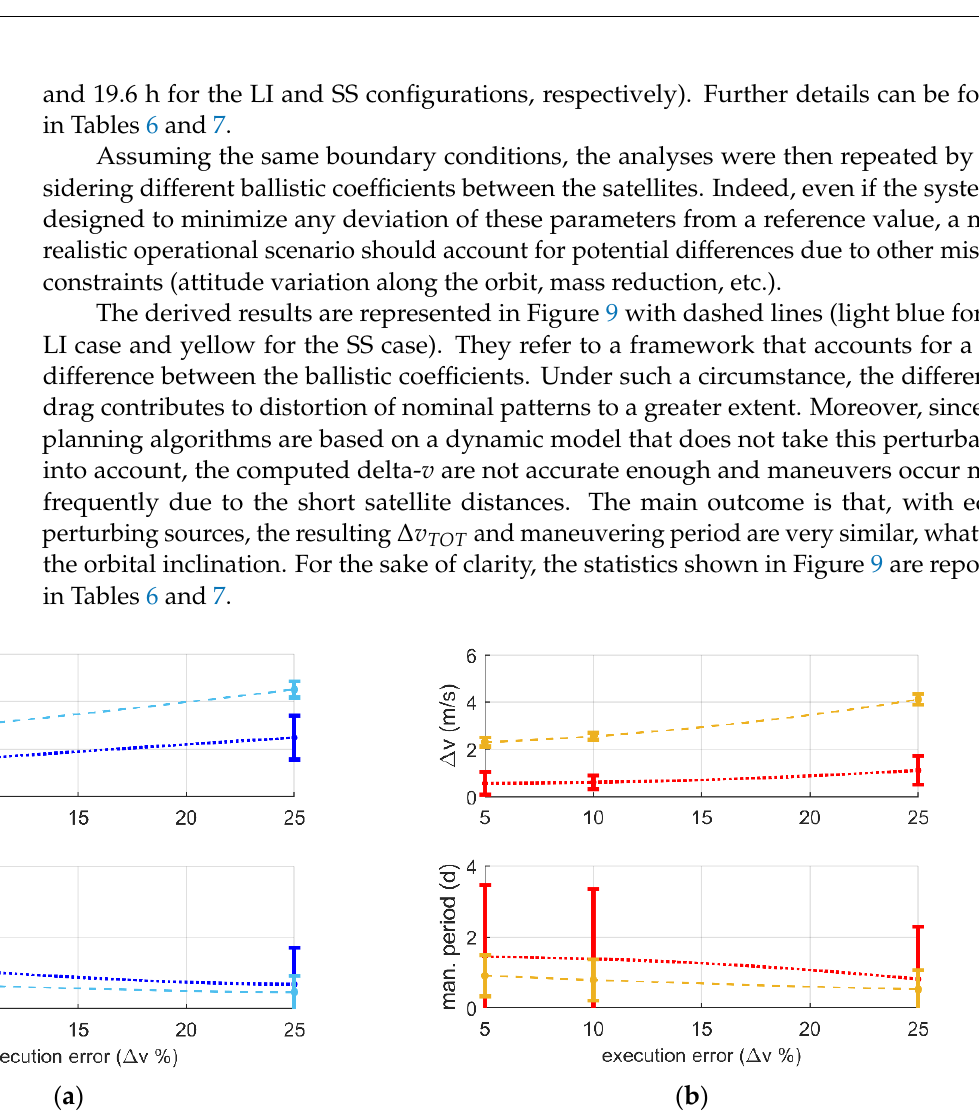
Figure 9. Sensitivity analyses for maintenance of low-inclined ( a ) and Sun-synchronous ( b ) formations in the presence of maneuvering execution errors and navigation errors ( σ p = 1 cm, σ p = 2.5 mm/s). Total ∆ v and maneuvering period over the first 30 days of mission— h = 550 km. Differently from the dotted lines, the dashed lines account for a 10% difference between ballistic coefficients. Table 6. Statistics related to the sensitivity analyses for maintenance of low-inclined formations in